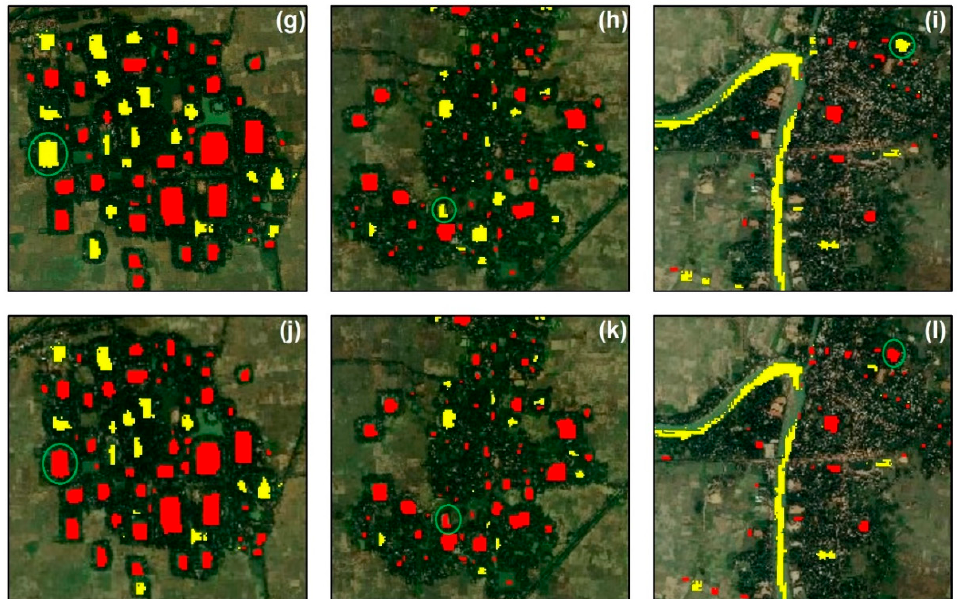
Figure 6. Fishpond classification results of three example subarea. Red polygons represent fishponds and yellow polygons represent water bodies identified by spectral filtering and rejected by spatial filtering. From top to bottom row: Automated Water Extraction Index (AWEI) image on 30 April 2020 ( a )–( c ), ground truth data ( d )–( f ), classification results by DT ( g )–( i ), classification results by LR ( j )–( l ). Green circles in subfigure ( g )–( l ) highlight differences between results obtained from DT and LR.